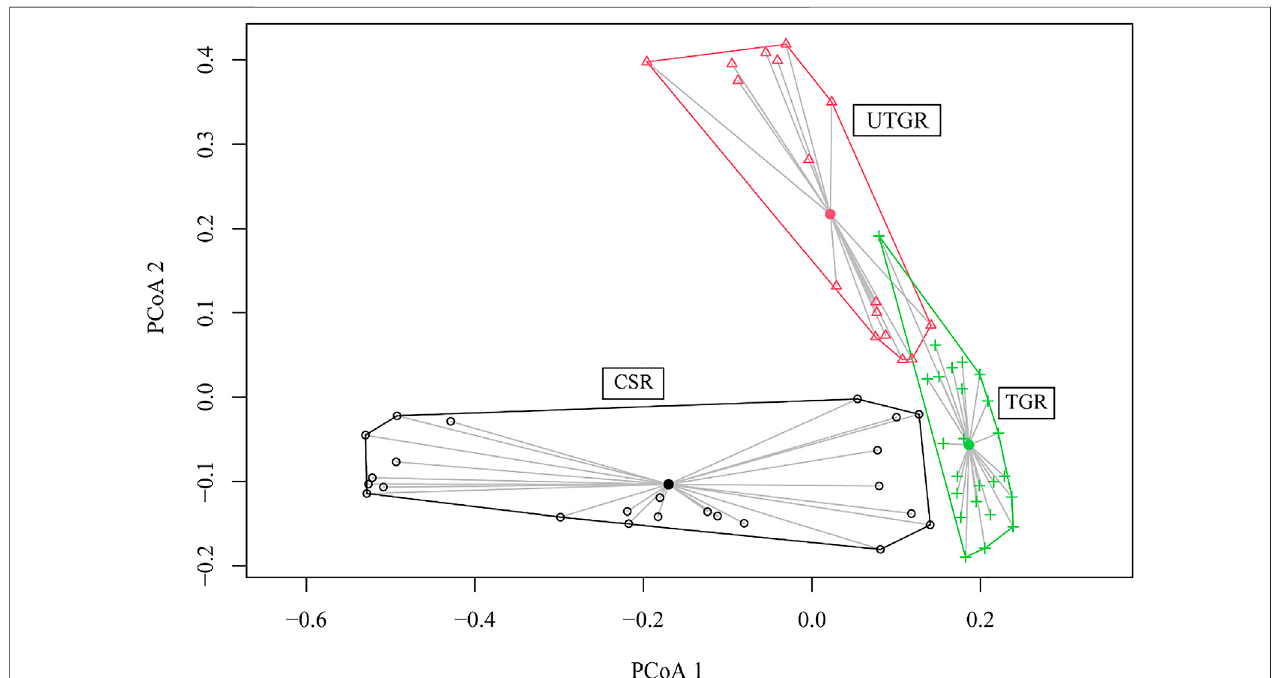
FIGURE 2 | Principal coordinate analysis of fi sh communities in the different habitat types in the upper reaches of the Yangtze River.